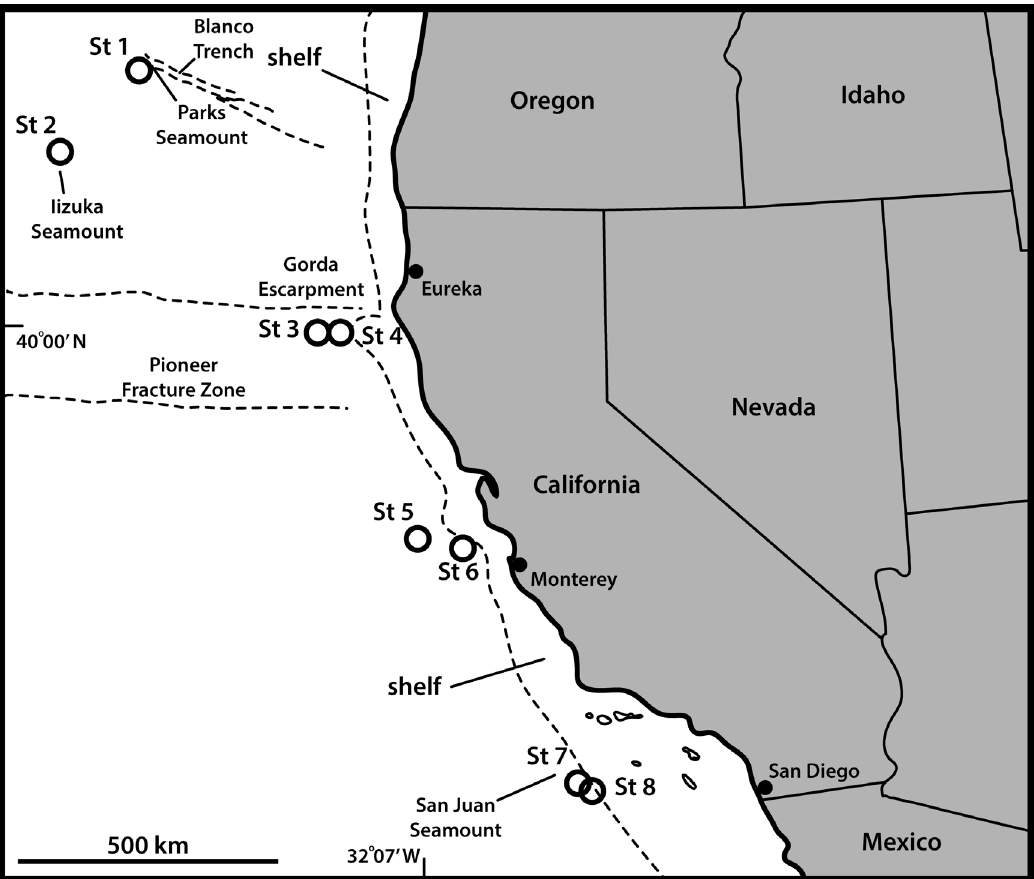
Fig. 1. Map showing the eight sampling stations off the US West Coast. See Table 1 for